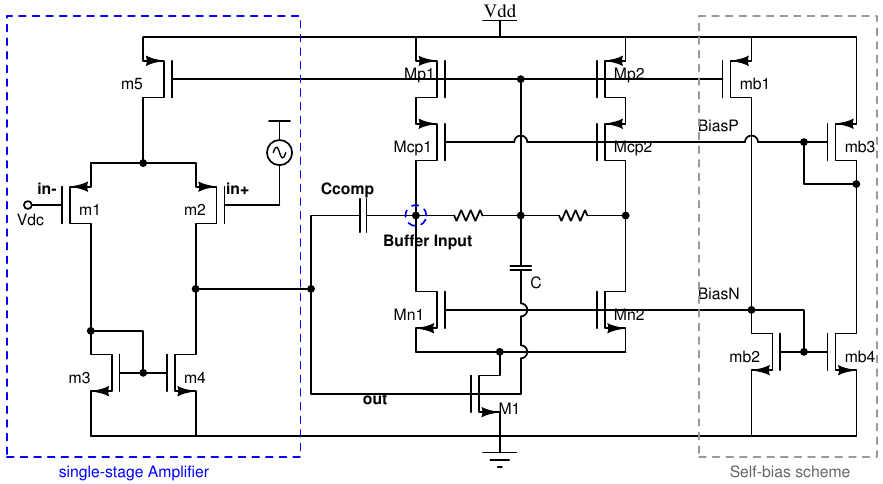
Figure 3. Open-loop configuration with a single-stage